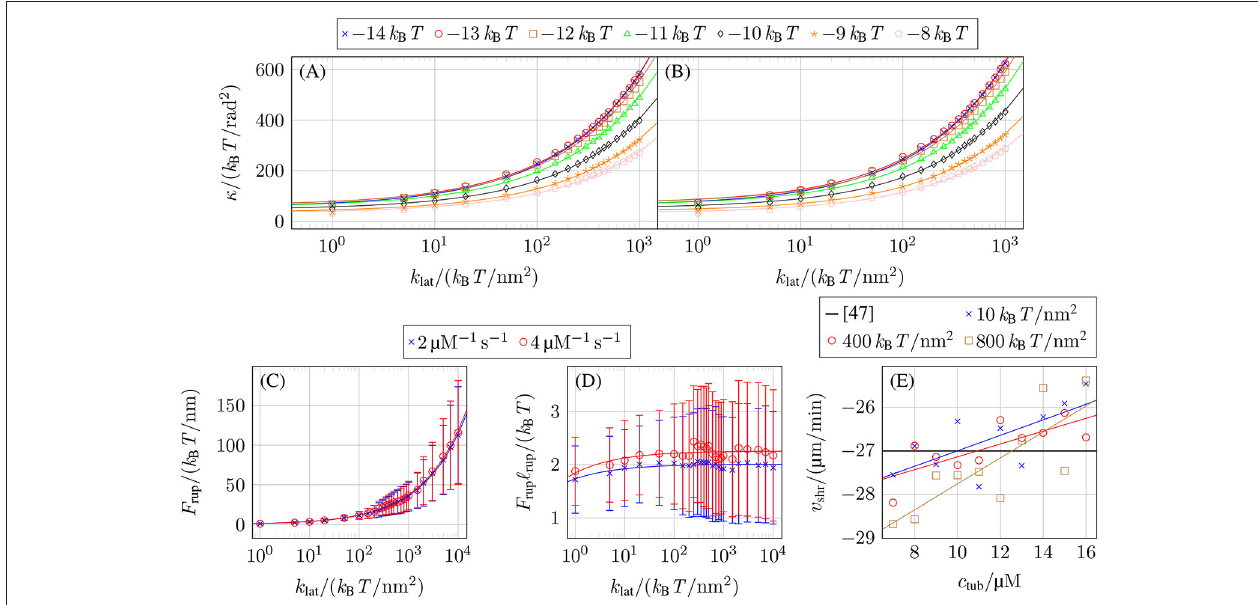
FIGURE 5 | Mechanical parameter values reproducing the experimentally measured shrinkage velocity in (17) for (A) k + = 2 µ M − 1 s − 1 and (B) k + = 4 µ M − 1 s − 1 and different values of 1 G 0 ∗ long . (C) Force on lateral bonds at rupture F rup as a function of k lat for k + = 2 µ M − 1 s − 1 with 1 G 0 ∗ long = − 9.5 k B T and k + = 4 µ M − 1 s − 1 with 1 G 0 ∗ long = − 9.0 k B T , both at c tub = 10 µ M. (D) Rupture energy F rup ℓ rup of lateral bonds as a function of k lat for the same parameters as in (C) . (E) Shrinkage velocity v shr as a function of the free tubulin dimer concentration c tub for k + = 4 µ M − 1 s − 1 , 1 G 0 ∗ long = − 9.3 k B T , and different values of k lat and linear fits v shr ( c tub